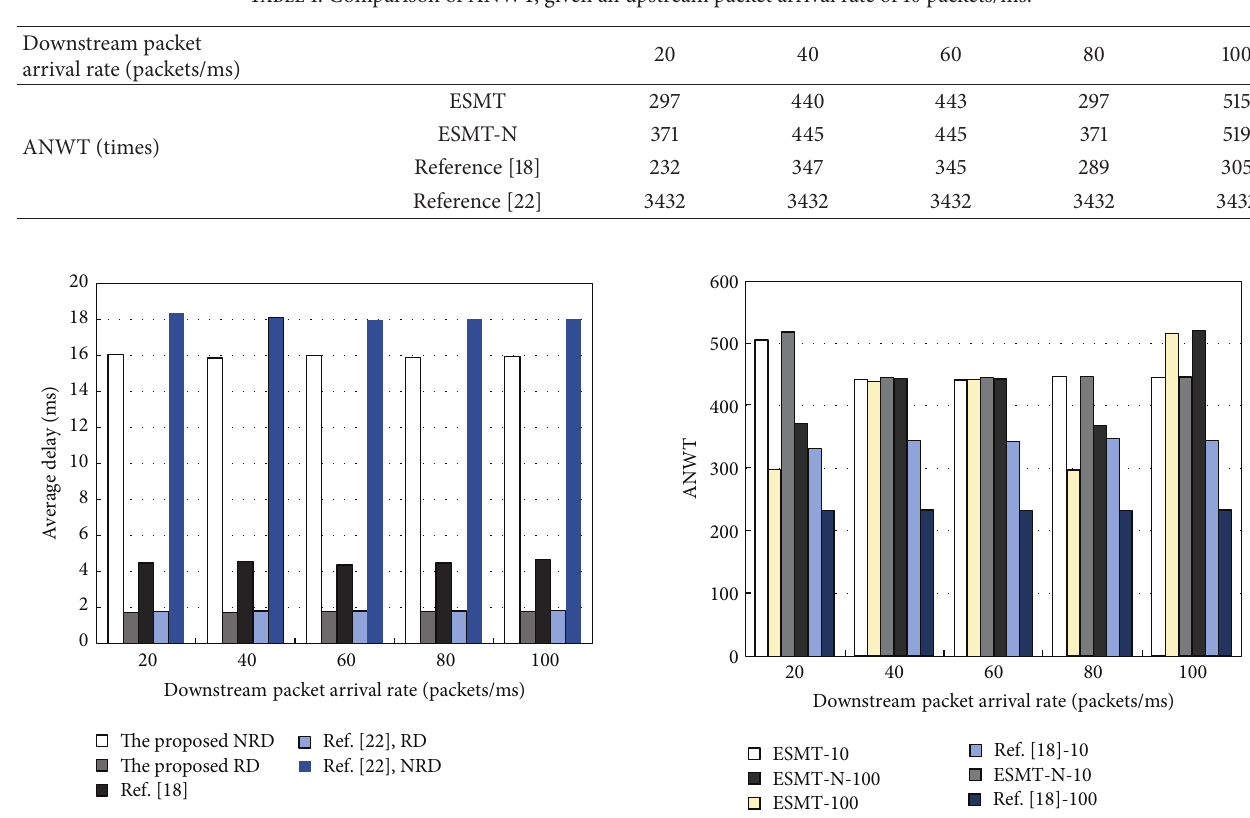
Table 1: Comparison of ANWT, given an upstream packet arrival rate of 10 packets/ms.